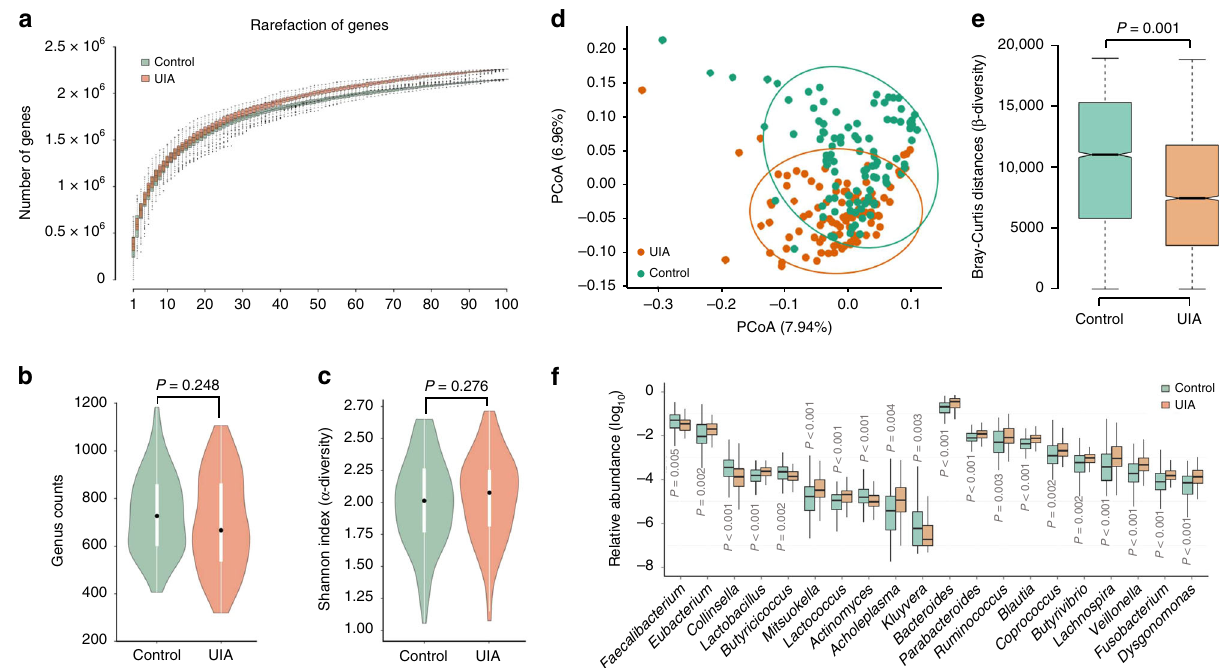
Fig. 1 Gut microbial alterations in UIA patients. a Rarefaction curves for gene number in controls ( n = 100) and UIA patients ( n = 100) after 100 random samplings. b , c Comparison of microbial genus counts and α -diversity (as assessed by the Shannon index) based on the genus pro fi les in the two groups. Interquartile ranges (IQRs; thick bars), medians (open dots on the bars), the lowest and highest values within 1.5 times IQR from the fi rst and third quartiles (lines above and below the bars). d Principal coordinate analysis of samples from UIAs and controls. e β -diversity (as assessed by the Bray – Curtis distances) based on the genus pro fi les in the two groups ( n = 100). f Relative abundances of the most abundant genera that showed signi fi cant differences between UIA patients and controls. For ( a ), ( e ), and ( f ), boxes represent the IQRs between the fi rst and third quartiles, and the line inside the box represents the median; whiskers represent the lowest or highest values within 1.5 times IQR from the fi rst or third quartiles. For ( b ), ( c ), and ( f ), the two- tailed Wilcoxon rank-sum test was used. For ( e ), ANOSIM analysis was performed. Source data are provided as a Source Data fi